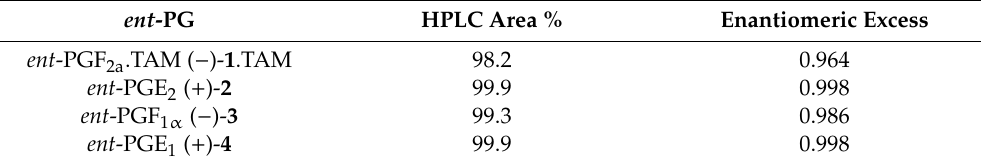
Table 3. Table 3. Table 3. Enantiopurity of the ent Table 3. Enantiopurity of the ent -prostaglandins. Table 3. Enantiopurity of the ent -prostaglandins. Table 3. Enantiopurity of the ent -prostaglandins. ent -PG